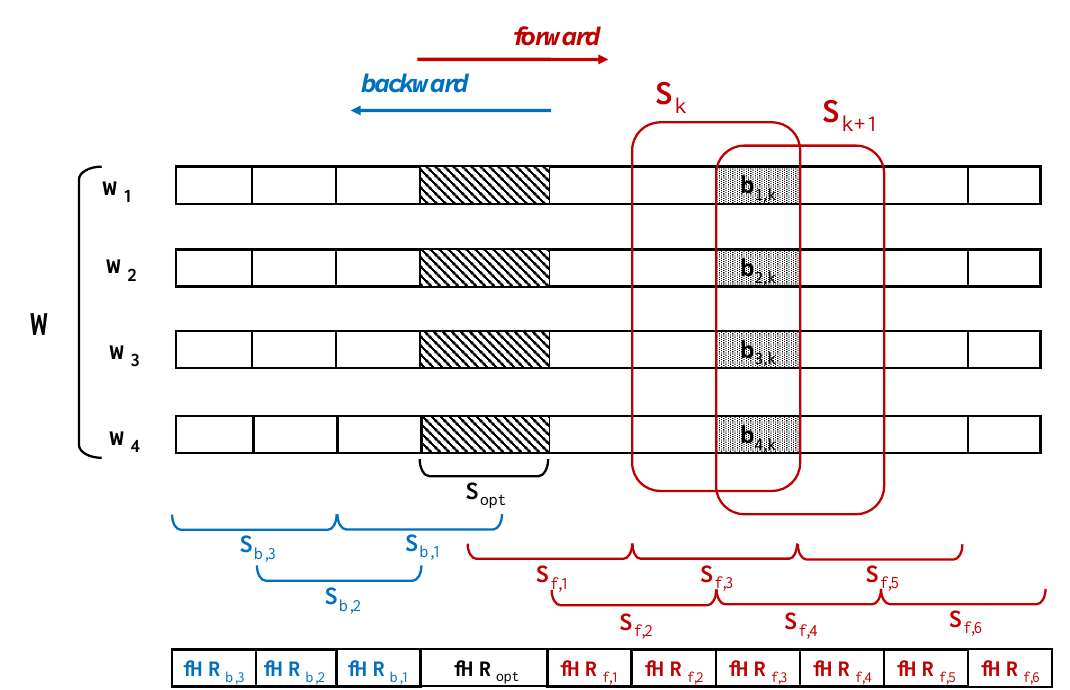
Figure 9. Signal segmentation scheme for the last step of the fHR estimation algorithm. fHR estimation was performed by means of the second detector, which was applied both in forward and in backward directions starting from the optimal segment. The detection of the fQRS proceeded in blocks according to the following procedure described for the generic block k : the k -th block b k , lasting 5 s, was part of both the segments S k